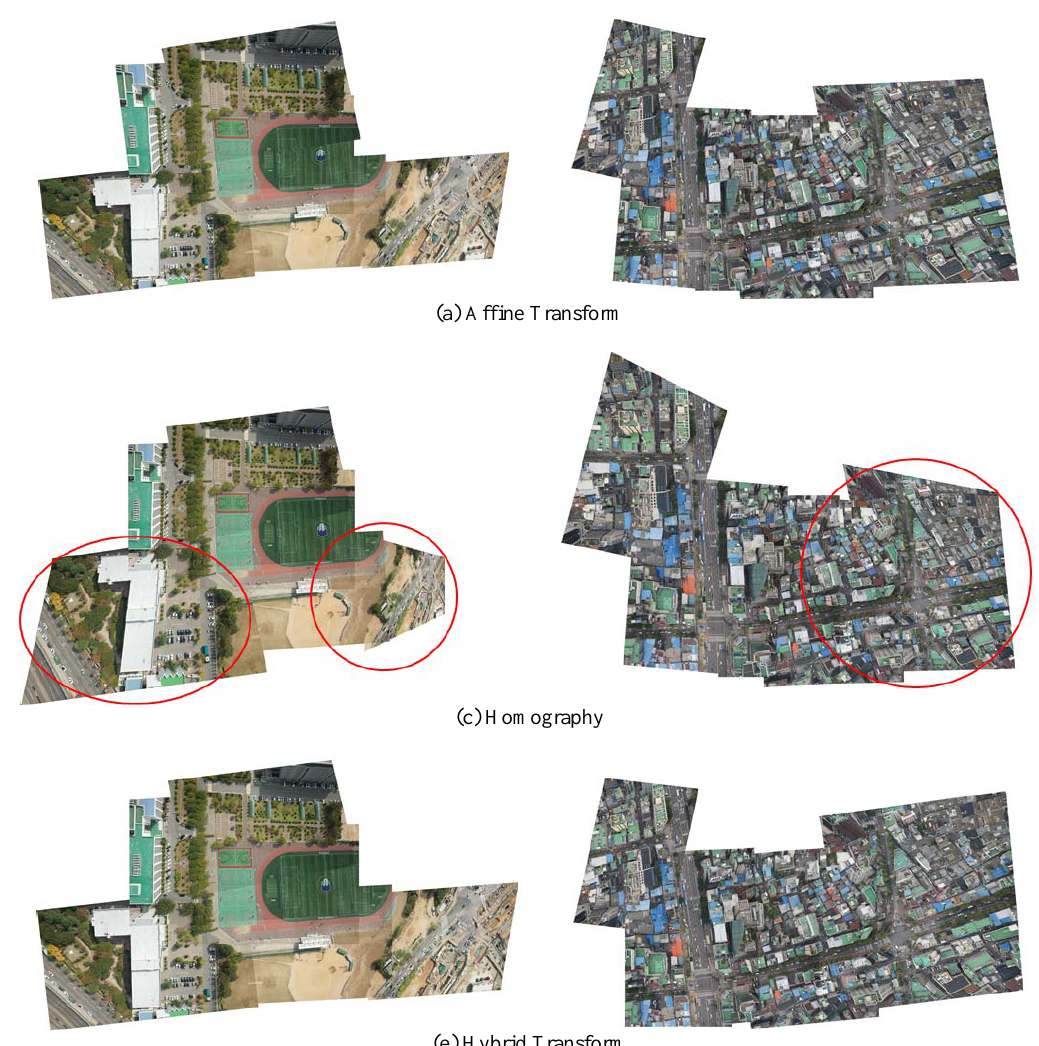
Figure 6. Mosaicking results for the subset of Dataset-2 and -3 (left column) and 3 (right